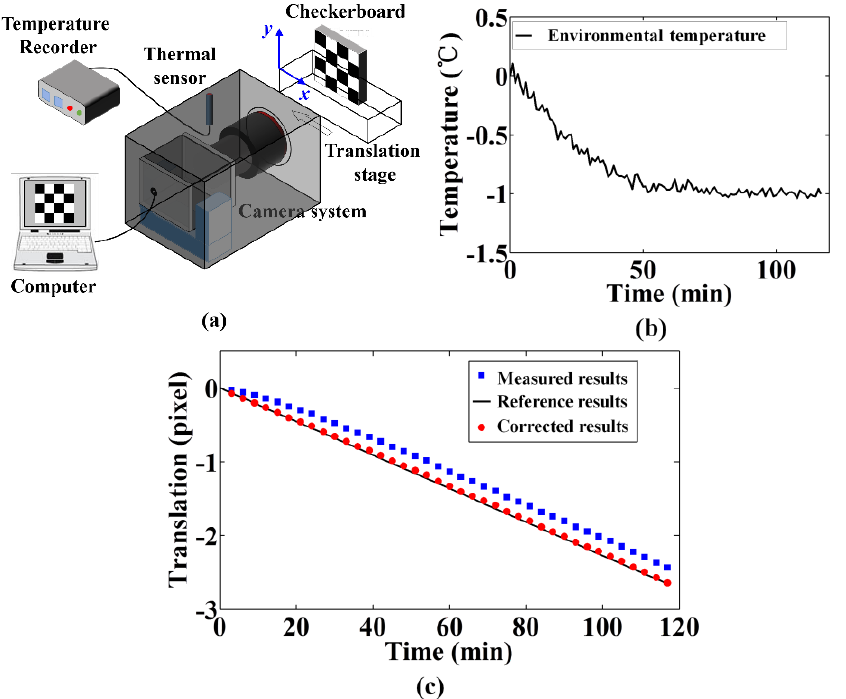
Figure 13. Experimental verification of the model compensation method for compensating the translation measurement error: ( a ) experimental arrangement, ( b ) environmental temperature during the experiment, and ( c ) experimental results.